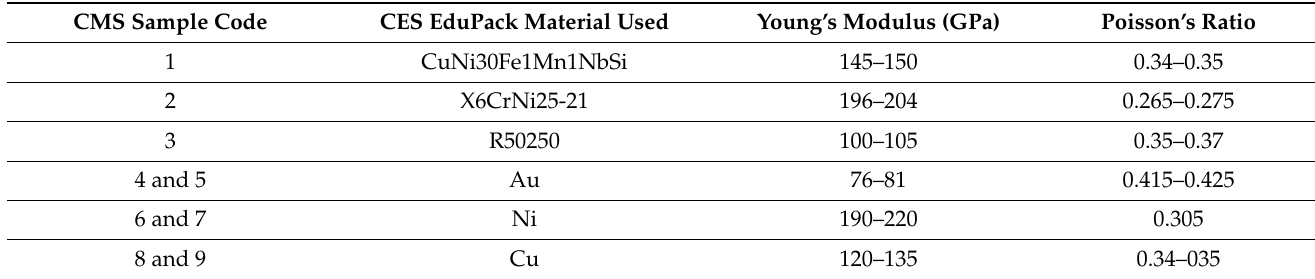
Table 3. Material properties used for strain analysis [31].